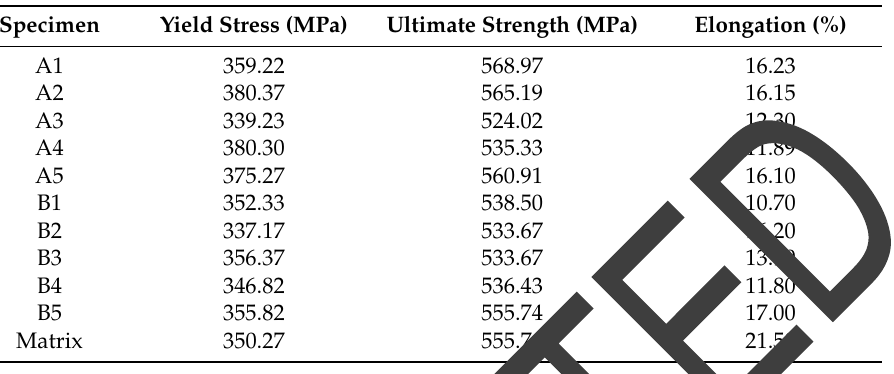
Table 3. Tensile simulation results for all specimens.